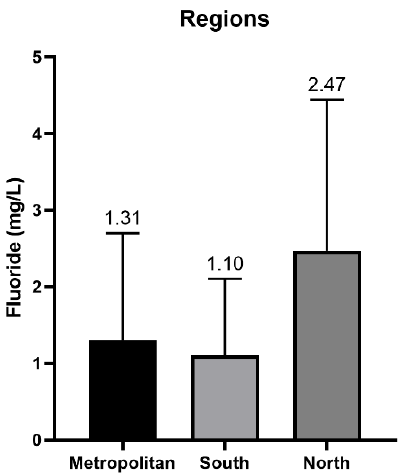
Figure 4. Fluoride content (mg/L) by regions in the Tenerife’s